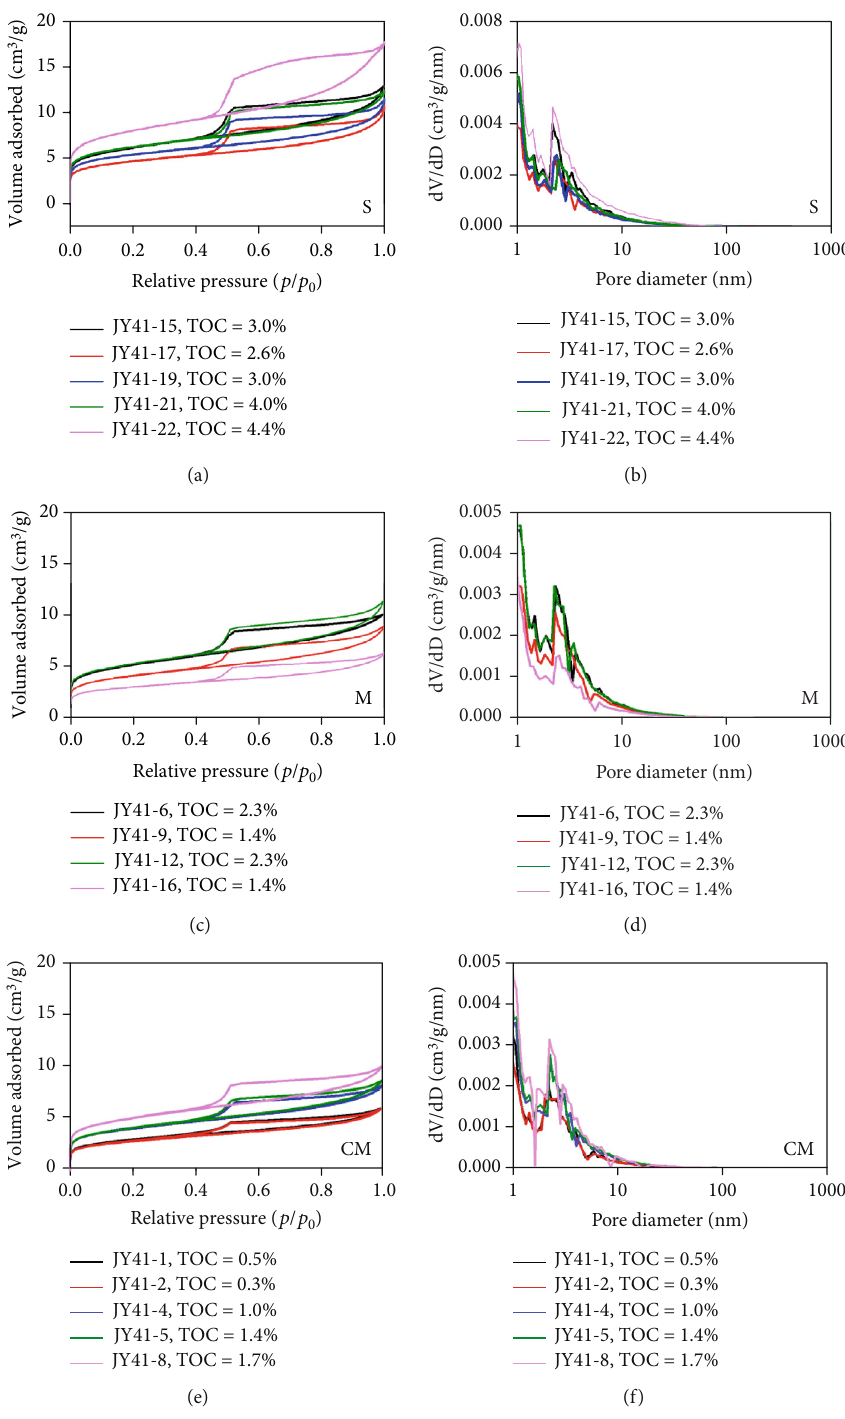
Figure 11: Low-pressure nitrogen adsorption isotherms and of pore size distributions of shale samples. (a, b) Siliceous shale lithofacies (S); (c, d) argillaceous/siliceous/calcareous mixed shale lithofacies (M); (e, f): silica-rich argillaceous shale lithofacies